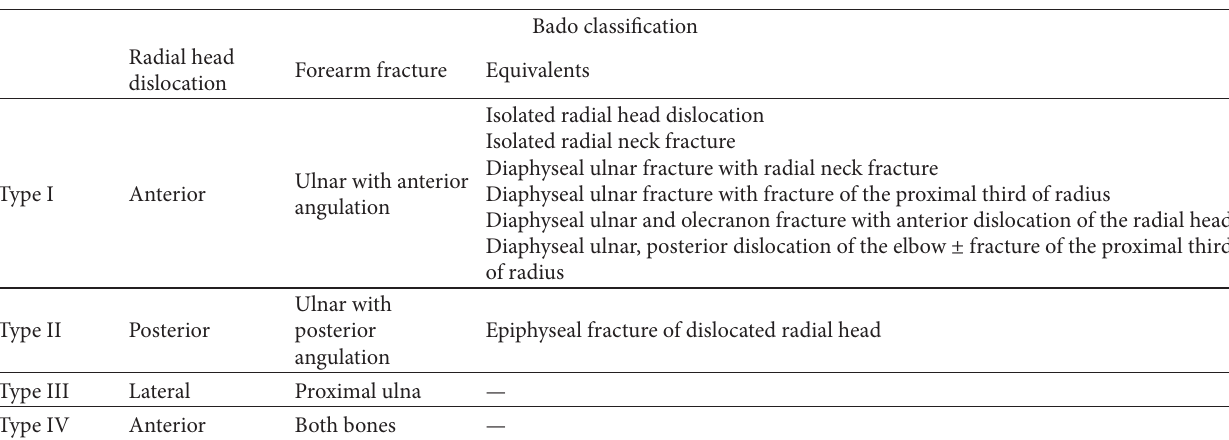
Table 1: Lateral radial head dislocation with concomitant both-bone forearm fracture fits in the Bado classification as a type 3 equivalent lesion, which has never been described